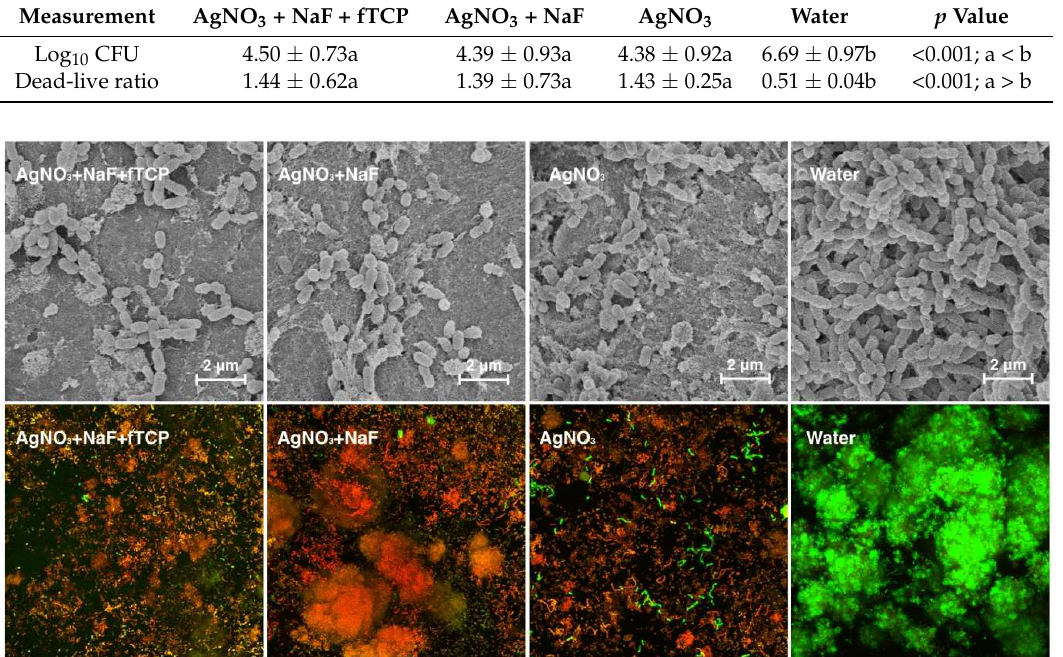
Table 1. Growth kinetics (log 10 CFUs) and viability (dead-live ratio) of S. mutans in the biofilm of the four treatment groups after seven days.